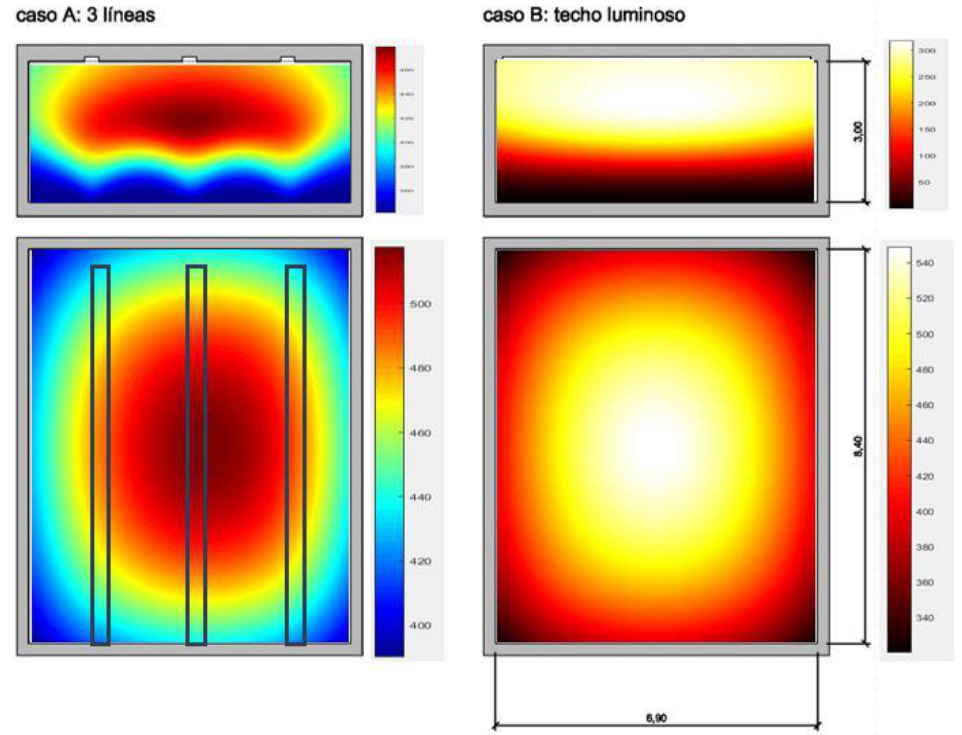
Figure 26. Superficial lighting vs. linear lighting. Calculations with DianaX by Lorenzo Muro and Joseph Cabeza-Lainez. Table 1. Surface lighting vs. linear lighting calculation with DianaX. Prepared by the authors. 3 lines (0.30 × 8.40 m)